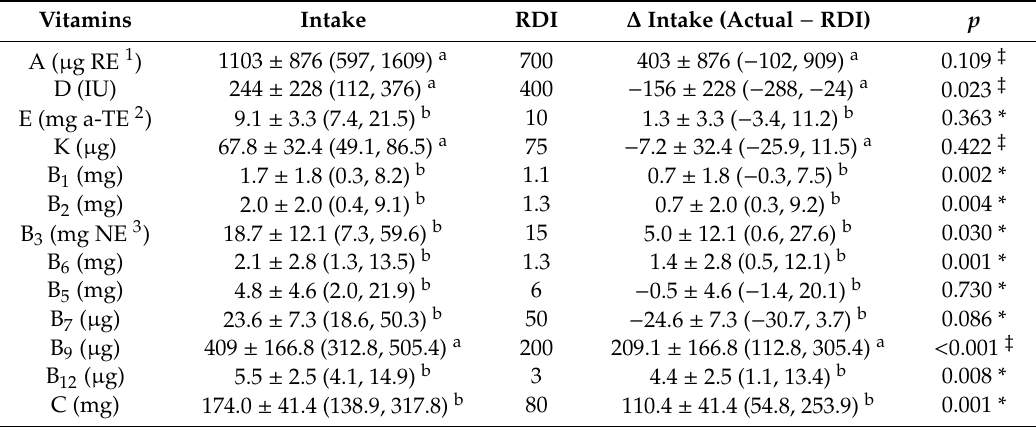
Table 4. Vitamin intake of deaf athletes.